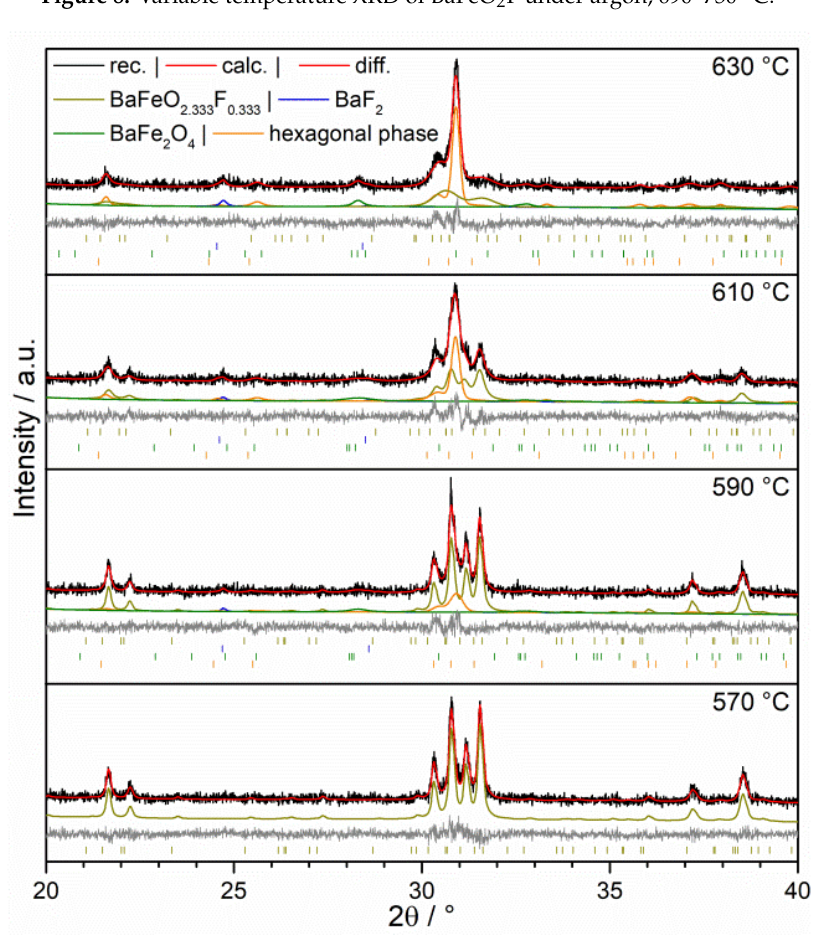
Figure 8. Variable temperature XRD of BaFeO 2 F under argon, 690–730 °C.